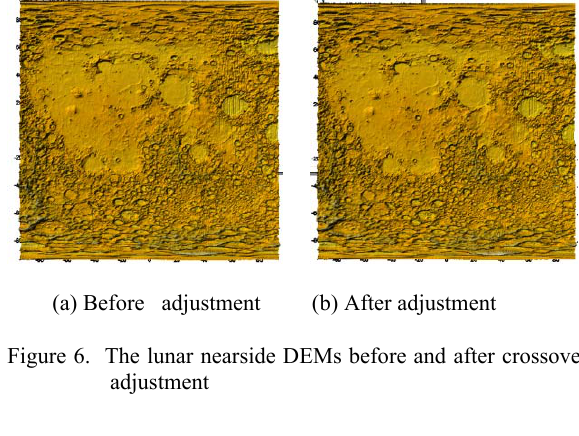
Figure 6. The lunar nearside DEMs before and after crossover